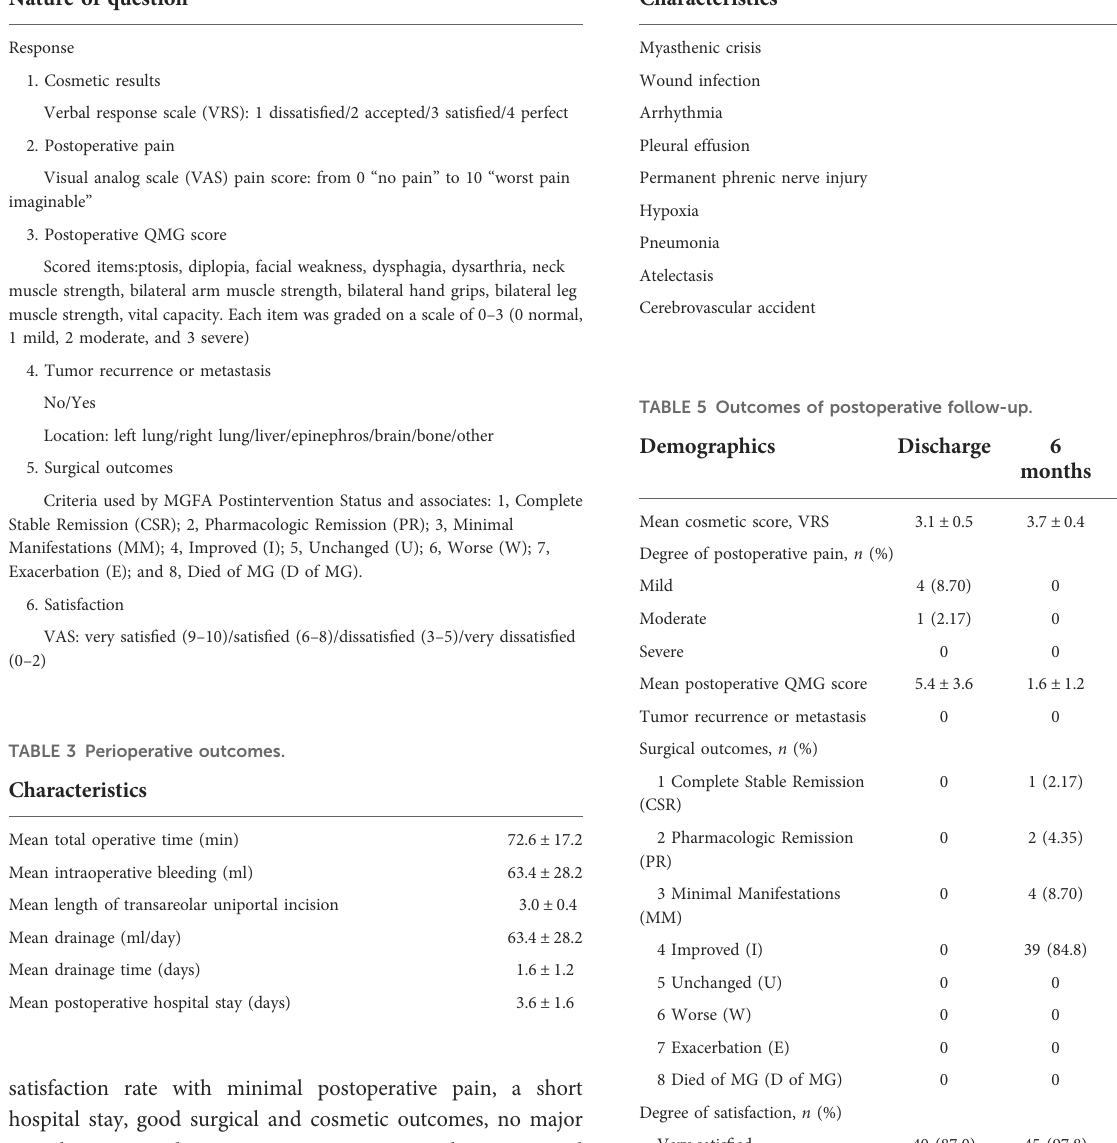
TABLE 4 Postoperative complications.